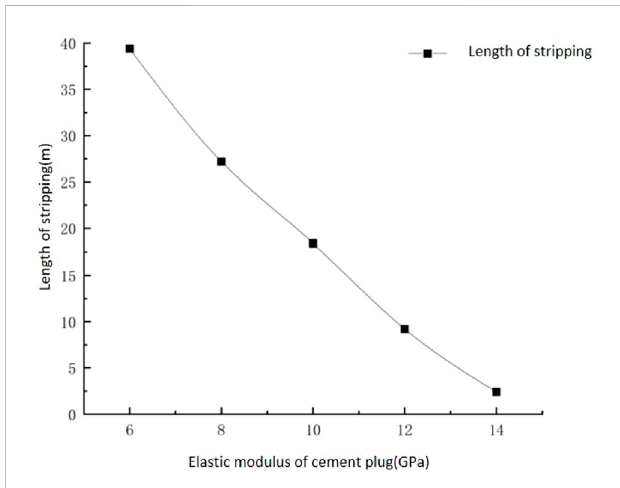
FIGURE 15 In fl uence of elastic modulus of cement plug on stripping length.